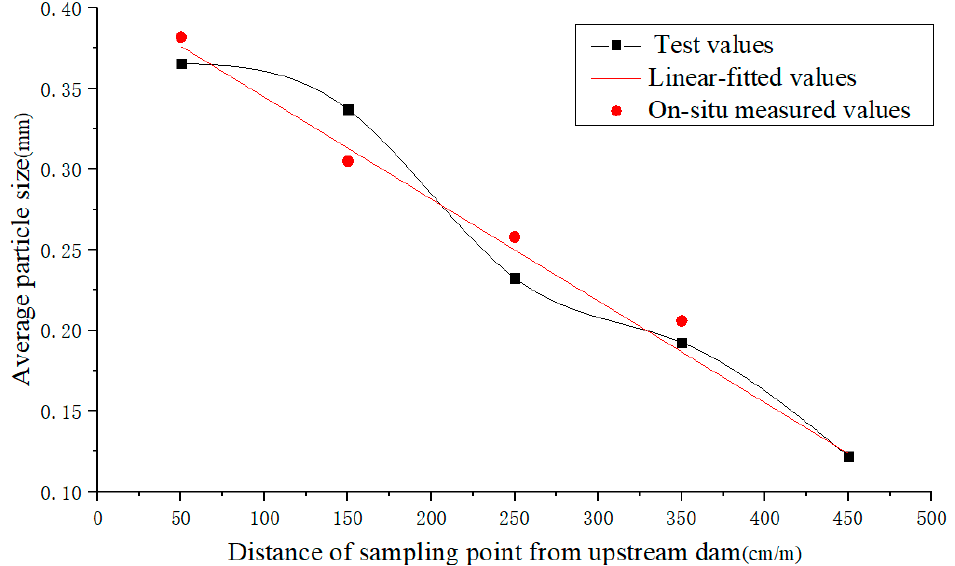
Figure 6. The relationship between average particle size D 50 and the distance of sampling point from upstream dam L .